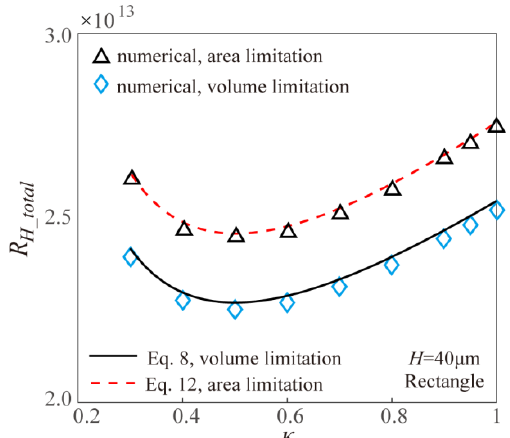
Figure 2. Comparison of theoretical and numerical results of electroosmotic flow (EOF) fluidic resistance within two Y-shaped microchannel bifurcations with different limitations.